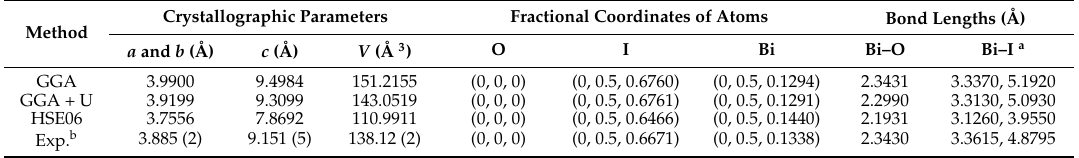
Figure 1. Crystal structure model of BiOI. Table 1. Optimized crystallographic parameters of BiOI obtained by different density functional theory (DFT) methods, as well as the experimental values. The atomic fractional coordinates of all of the atoms and bond lengths are also given.